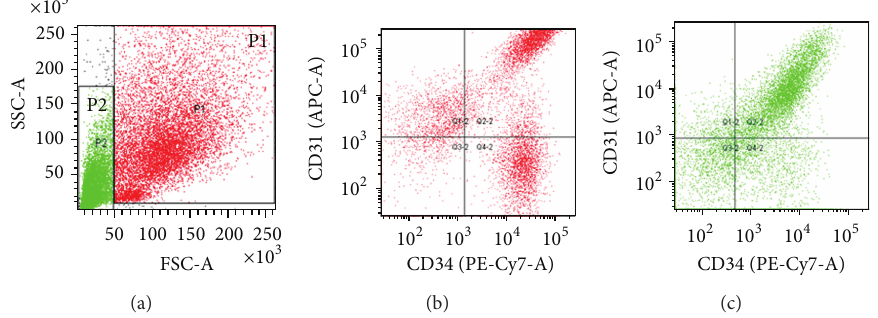
Figure 1: Detection of ASC, EPC, and EC populations in SVF with respect to cell size. The figure shows a representative flow cytometry scatter profile for SVF cells that have been stained with fluorescent tagged antibodies against the cell surface markers CD31 and CD34. (a) Forward scatter (FSC) and side scatter (SSC). Events in gates P1 and P2 represent the FSC hi and FSC lo populations, respectively. (b) Detection of FSC hi cells expressing CD31 and CD34. (c) Detection of FSC lo cells expressing CD31 and CD34.